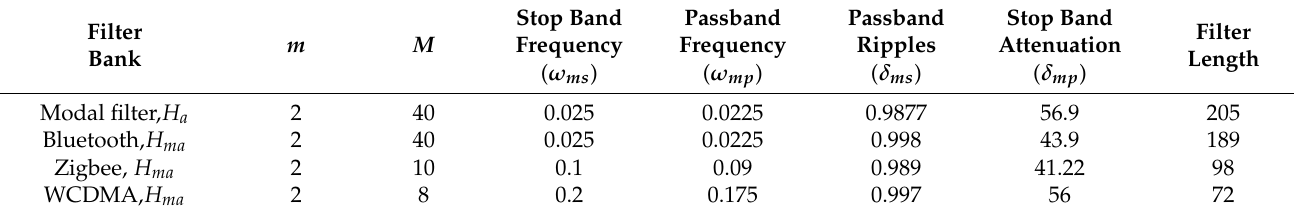
Table 2. The frequency characteristics of the modulated Farrow filter when m = 2, k = 2.